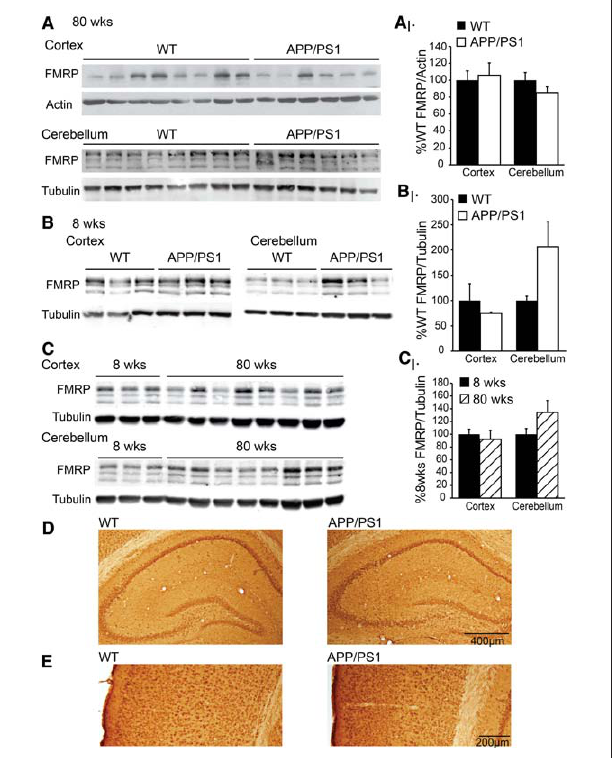
FIGURE 2 | FMRP expression in AD model APP/PS1 mice. (A) Cortical and subcortical, and cerebellar lysates from 80-week-old APP/PS1 ( n = 6) and age-matched controls ( n = 8) probed with the 17722 α -FMRP antibody and actin or tubulin. (A1) FMRP/actin values were calculated and normalized to WT levels, and expressed as %WT in the quantification. Results are the summary of values calculated in technical triplicate. (B) Eight-week-old APP/PS1 ( n = 3) and WT littermate controls ( n = 3) were compared for FMRP expression in cortical and subcortical and cerebellar lysates. (B1) FMRP/tubulin values are expressed as %WT, and data are the summary of experiments performed in technical triplicate. (C) Eight-week-old WT ( n = 3) and 80-week-old WT ( n = 8) cortical and cerebellar lysates compared for FMRP expression. (C1) FMRP/tubulin values are expressed as percentage of mean 8-week-old samples, and data are the summary of experiments performed in duplicate. (D) Hippocampal FMRP expression using the 1C3 α -FMRP antibody in WT and APP/PS1 mice. (E) Cortical FMRP in the same mice as in (D)